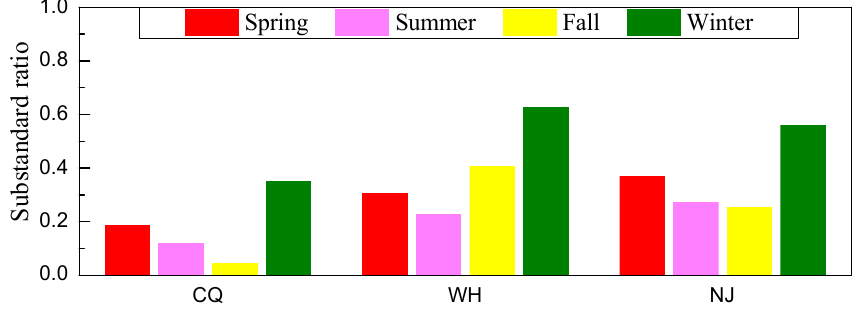
Figure 5. Seasonal variation of substandard ratio in Chongqing (CQ), Wuhan (WH) and Nanjing (NJ).